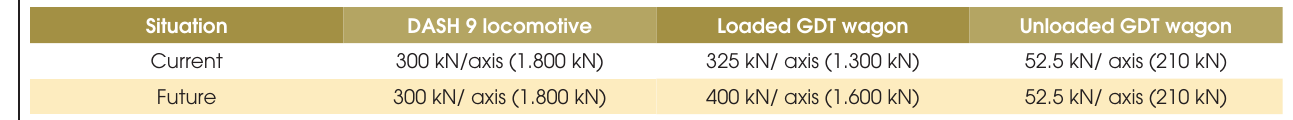
Table 3 – Loads per axis of the